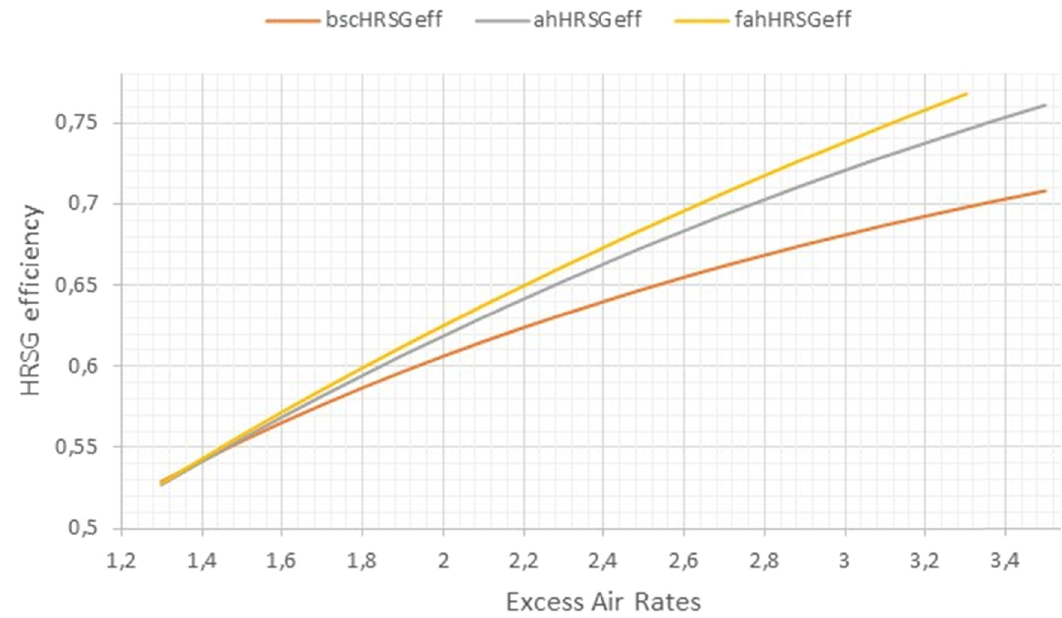
Figure 18: Variation of the HRSG e ffi ciency with excess air rates for bsc, ah and fah cogeneration